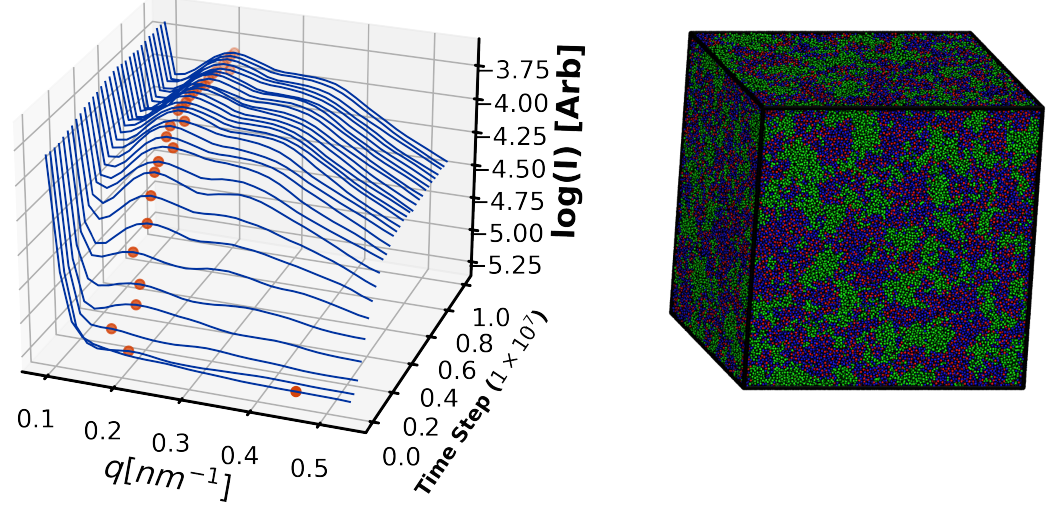
Figure 7. ( A ) Structure factor evolution of PES correlations for N = 1 × 10 6 is used to quantify equilibration. Red symbols indicate the wavenumber q max of a local maximum in S ( q ) . ( B ) representative N = 1 × 10 6 morphology after achieving steady